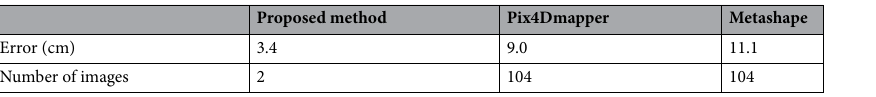
Table 4. Errors of the proposed method and the two conventional methods for the first experiment.